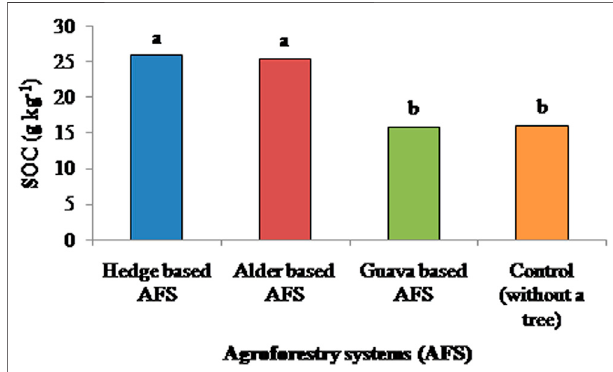
FIGURE 3 | Effects of various agroforestry systems on soil organic carbon (SOC) in the soil depth of 0 – 30 cm of the Indian sub-Himalayas. (Means of different land use systems within a column followed by similar lowercase letters are not signi fi cant at p < 0.05 based on Tukey ’ s HSD